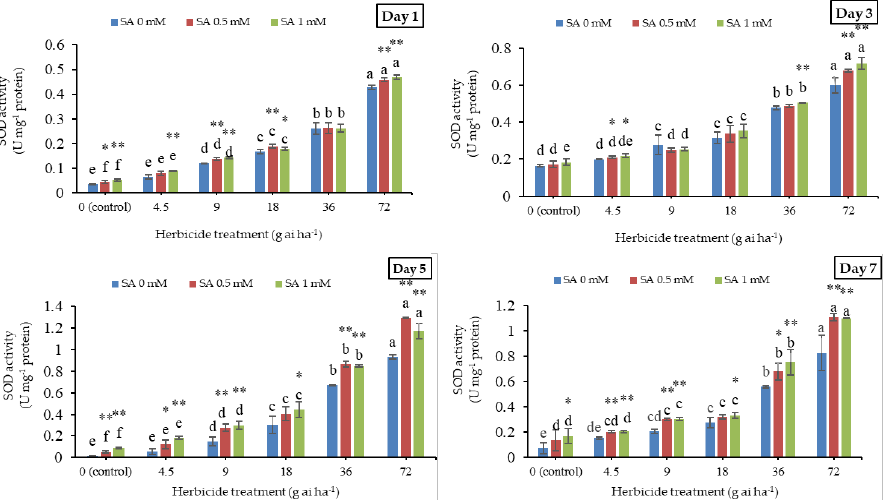
Figure 3. Changes in superoxide dismutase (SOD) activity in the leaf tissues of wheat at 1, 3, 5, and 7 days after herbicide application at different rates. The leaves were pre-treated with different concentrations of salicylic acid (SA) 3 days prior to herbicide application. The bars represent the treatment mean ± SD ( n = 4), and the bars with different lower-case letters were significantly ( p ≤ 0.05) different, according to the Duncan ’ s test. Asterisks indicate significant difference between the herbicide only and herbicide with each concentration of SA, according to the Independent Samples t - test.